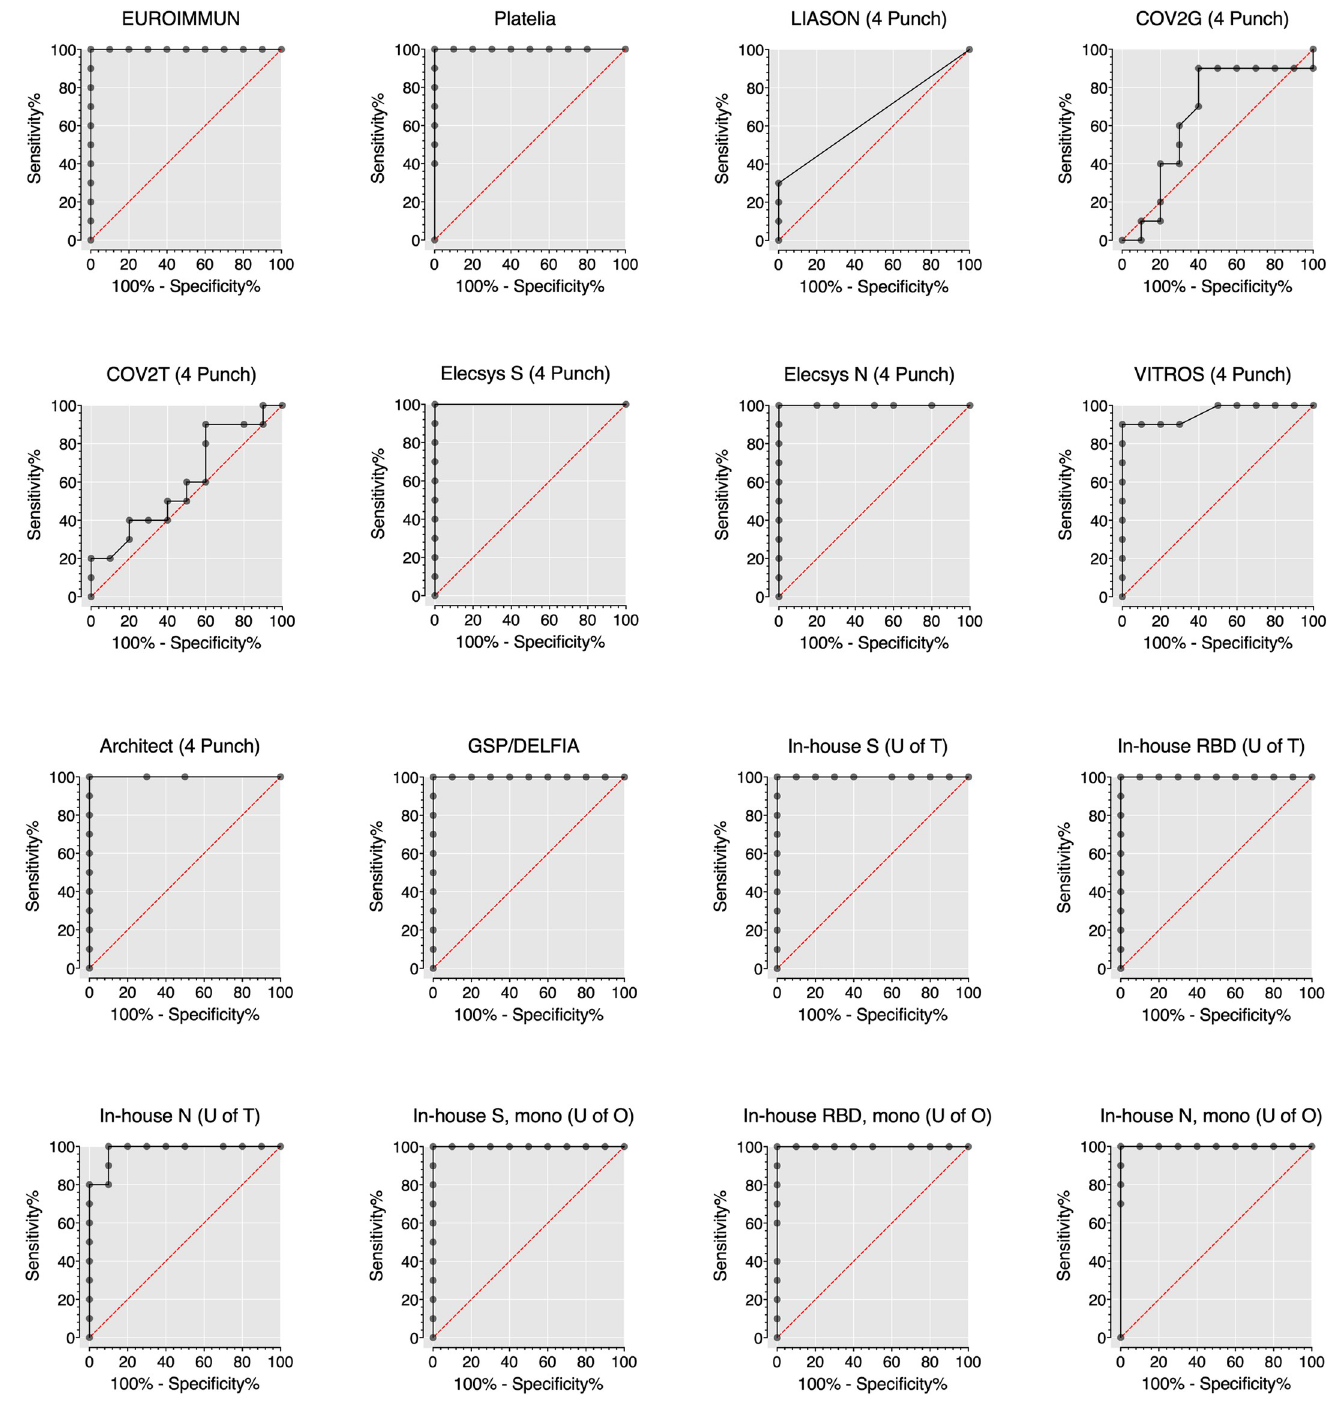
Fig 3. Receiver operating characteristic (ROC) curve for each commercial and in-house assay on dried blood spot specimens. ROC curves are presented for n = 10 SARS-CoV-2 antibody negative DBS specimens and n = 10 SARS-CoV-2 antibody positive DBS specimens. One 6 mm (1/4 inch) punch was used for the EUROIMMUN assay and two 6 mm (1/4 inch) punches were used for the Platelia and in-house assays. Data from four 6 mm (1/4 inch) punches is presented for all other assays. EUROIMMUN = Anti-SARS-CoV-2 ELISA assay (EUROIMMUN, Lu¨beck, Germany). Platelia = SARS-CoV-2 assay (Bio-Rad, Hercules, California). LIASON = SARS-CoV-2 assay (DiaSorin, Saluggia, Italy). COV2G = SARS-CoV-2 COV2G assay (Siemens, Erlangen, Germany). COV2T = SARS-CoV-2 COV2T assay (Siemens). Elecsys S = Quantitative Anti-SARS-CoV-2 assay (Elecsys spike; Roche, Basel, Switzerland). Elecsys N = Anti-SARS-CoV-2 assay (Elecsys nucleocapsid; Roche). VITROS = Anti-SARS-CoV-2 assay (Ortho Clinical Diagnostics, Raritan, New Jersey). Architect = SARS-CoV-2 assay (Abbott, Mississauga,